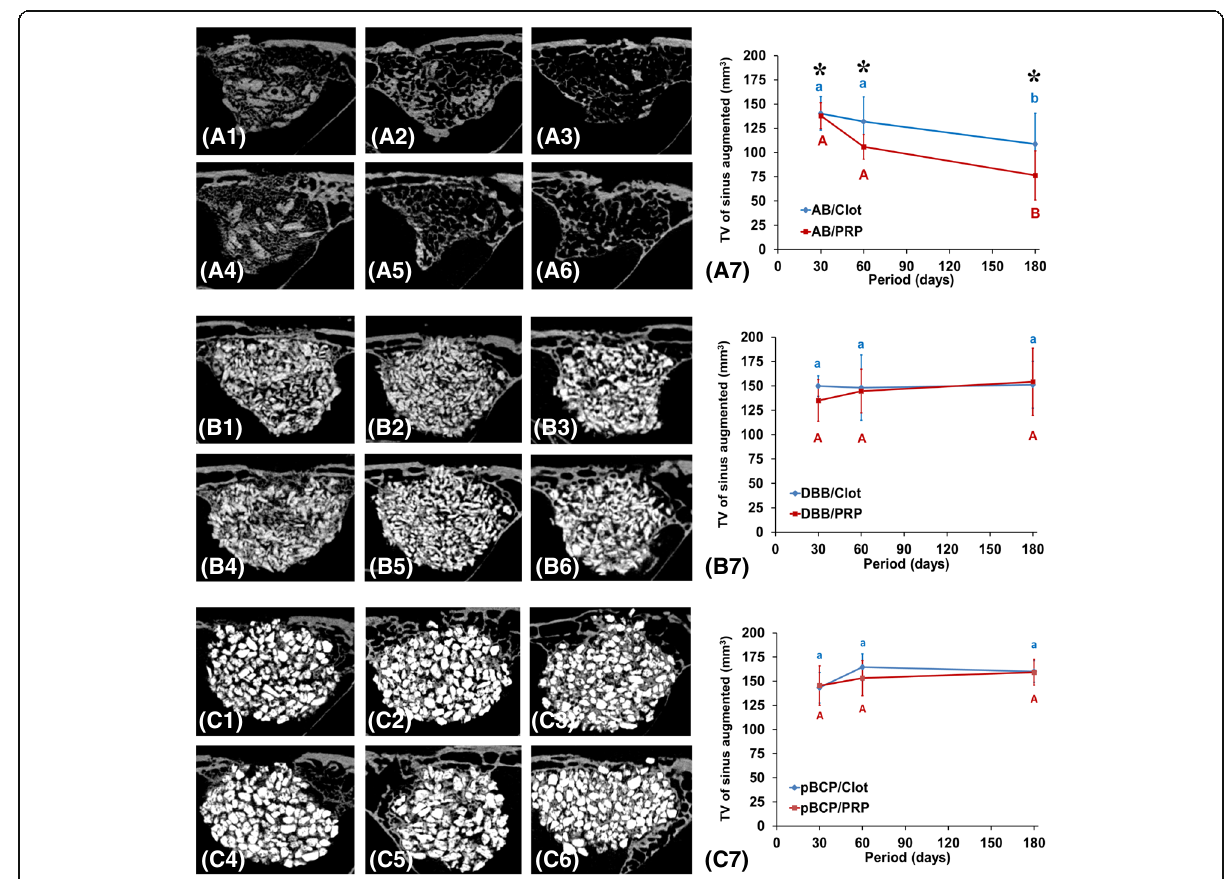
Fig. 2 Micro-CT evaluation. a 2D microCT – panoramic view: sagittal images show in AB treatment at 30 days large AB particles with the presence of fine bone trabeculae being more evident in the AB/PRP group than AB/clot At 60 and 180 days gradual reduction of AB particles with formation of thicker but less frequent bone trabeculae. In DBB and pBCP with clot and PRP show particles hyperdense than remaining bone tissue. Between 30 and 180 days, an increase of isodense areas in the space between particles referent to new bone tissue is shown. b TV of sinus augmented: graphs of evolution of MSA volume obtained by AB/clot and AB/PRP ( A7B1 ), DBB/clot and DBB/PRP ( B7B2 ), and pBCP/clot and pBCP/PRP ( C7B3 ). Different letters p < 0.05 among groups and